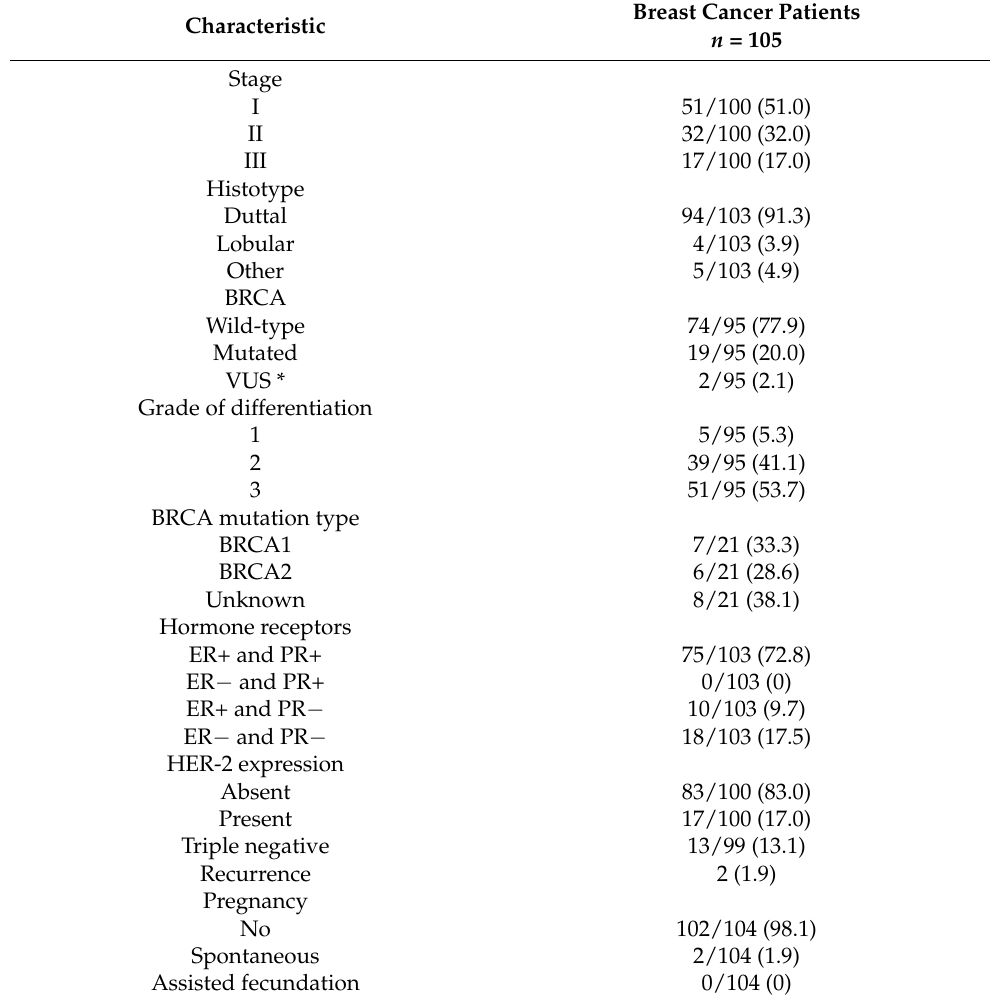
Table 2. Pathological and clinical characteristics of the 105 cancer patients included in the